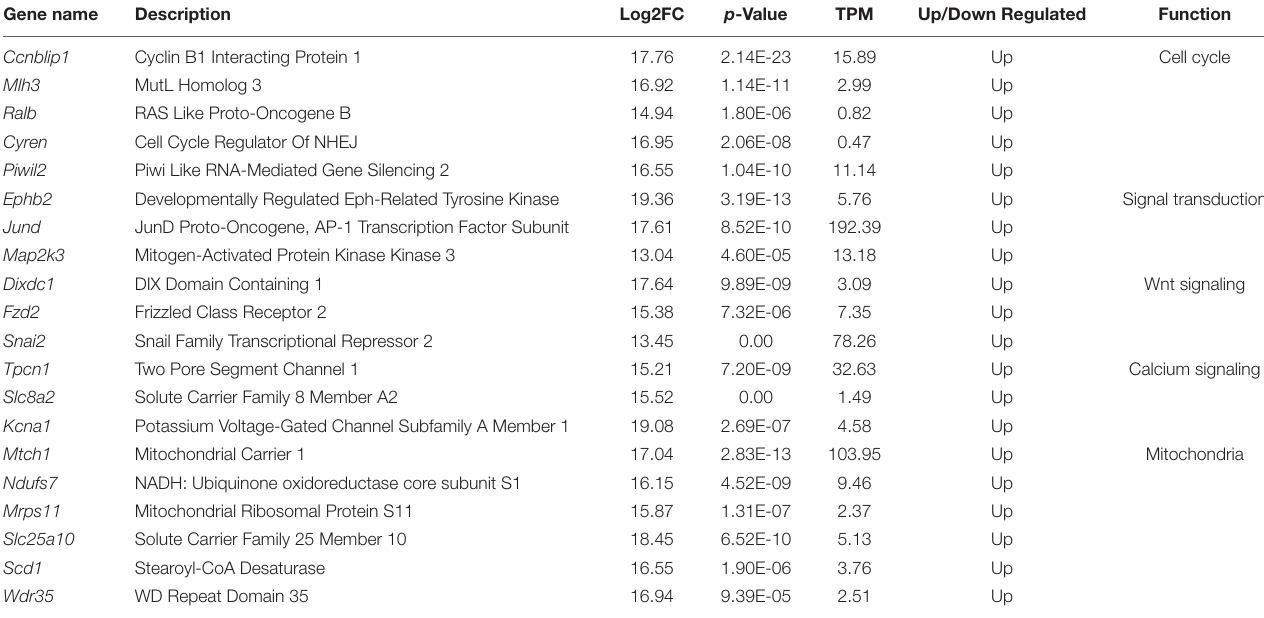
TABLE 4 | Top most significant DEGs in MII oocytes between in vivo and in vitro